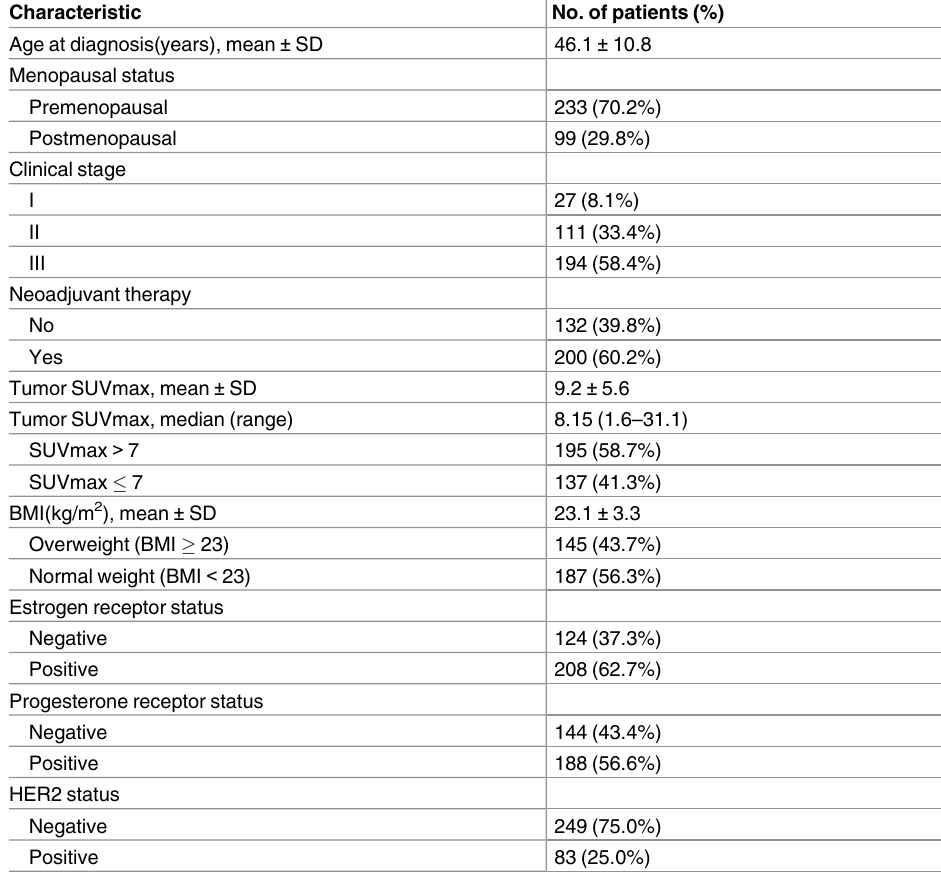
Table 1. Clinical characteristics of study subjects with breast cancer (n = 332).